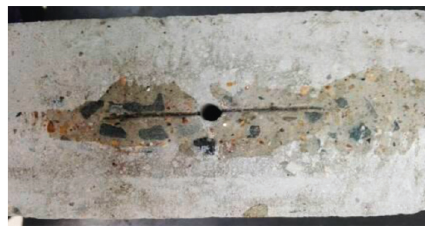
Table 3: Initial saturation of the test